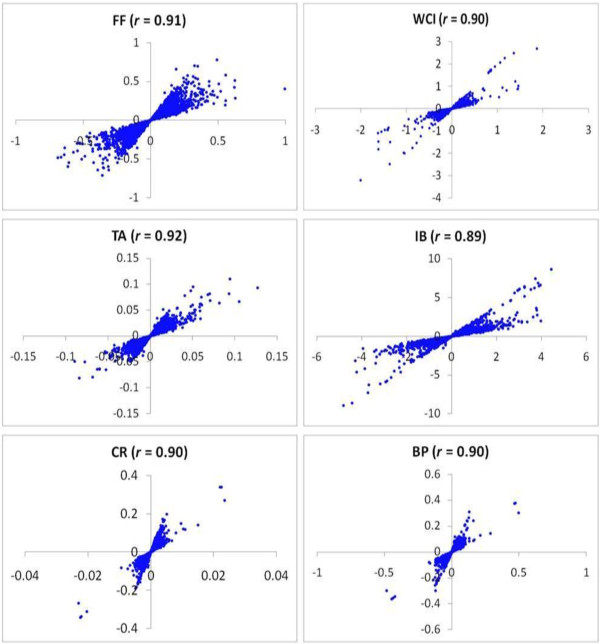
Relationship between single nucleotide polymorphism (SNP) allele substitution effects obtained from single-SNP (y-axis) and all-SNP (x-axis) analysis. Correlation coefficient (r) is also shown for each trait.